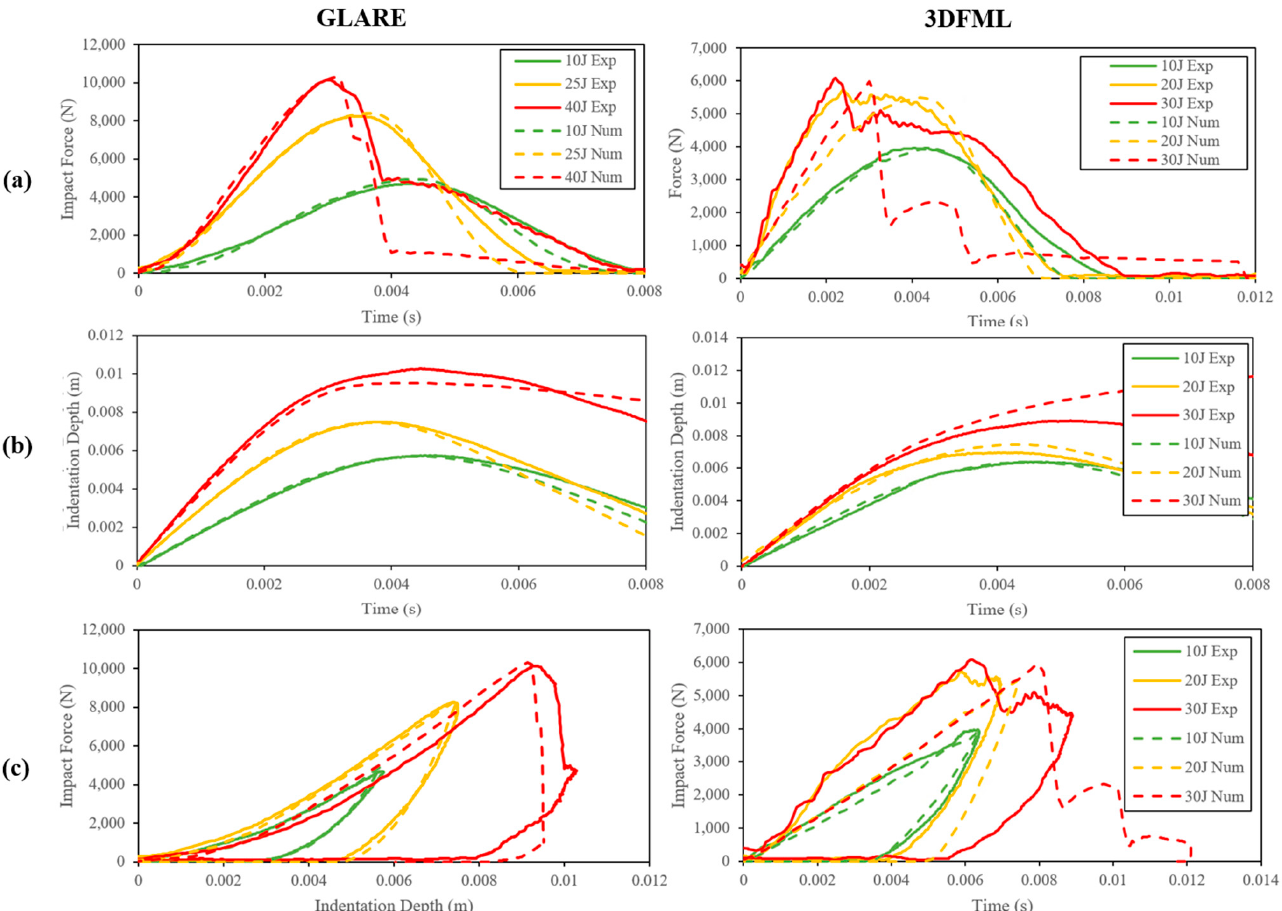
Figure 8. The low-velocity impact test results: plots of ( a ) impact force vs. time; ( b ) indentation depth vs. time; ( c ) impact force vs. displacement.